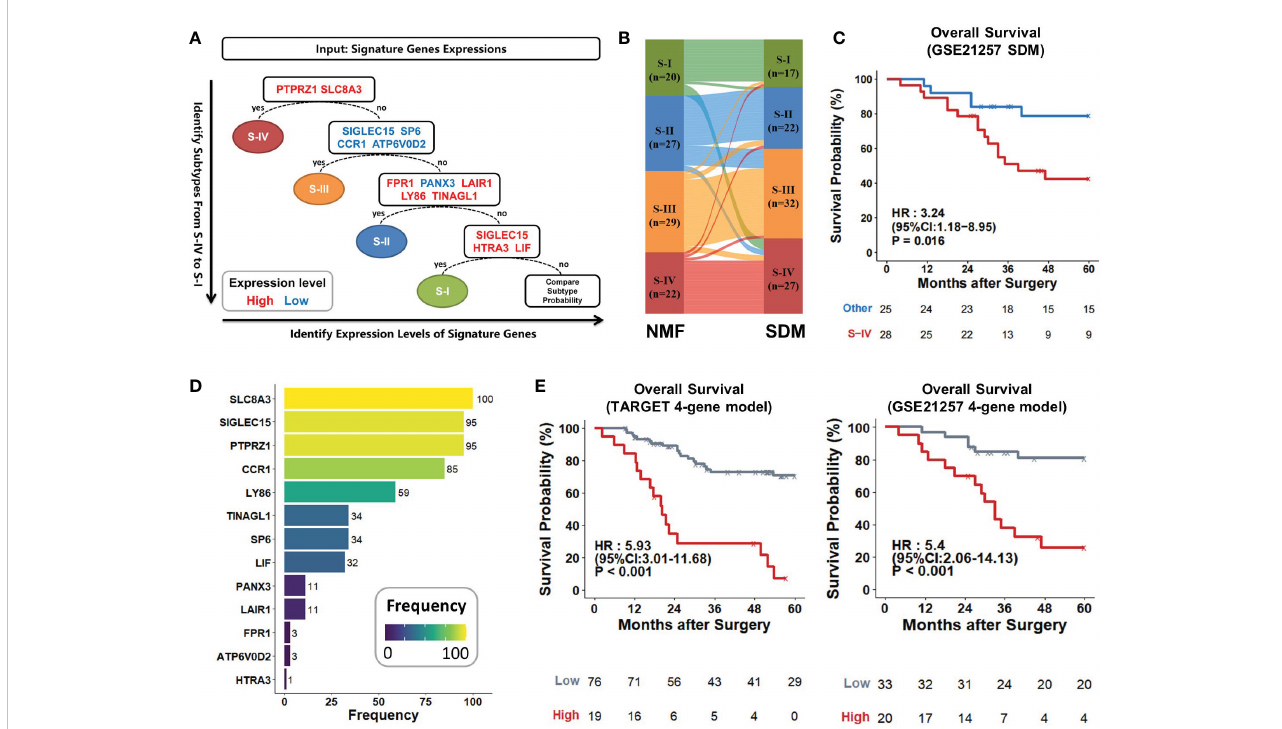
FIGURE 7 Establishment and evaluation of two predictive models. (A) Schematic work fl ow of the subtype diagnostic model. Osteosarcoma patients were sequentially strati fi ed according to 13 marker genes with high (red) or low (blue) expressions. (B) Sankey diagram showed that subtypes identi fi ed by SDM matched very closely with those by the NMF method. Each rectangle represented a subtype, and each row represented a patient sample. The connection degree was visualized based on the size of rectangles. (C) Kaplan – Meier curves of S-IV and other patients predicted by SDM in the GSE21257 dataset (S-IV, n = 28; others, n = 25). (D) PTPRZ1, SLC8A3, SIGLEC15, and CCR1 were the top four genes that were selected most frequently within the 100 iterations. They were retained to develop the LASSO model. (E) Kaplan-Meier curves. The 4-gene model with high scores led to poorer outcomes compared to the low in the TARGET cohort and GSE21257 dataset. P values were calculated by log-rank